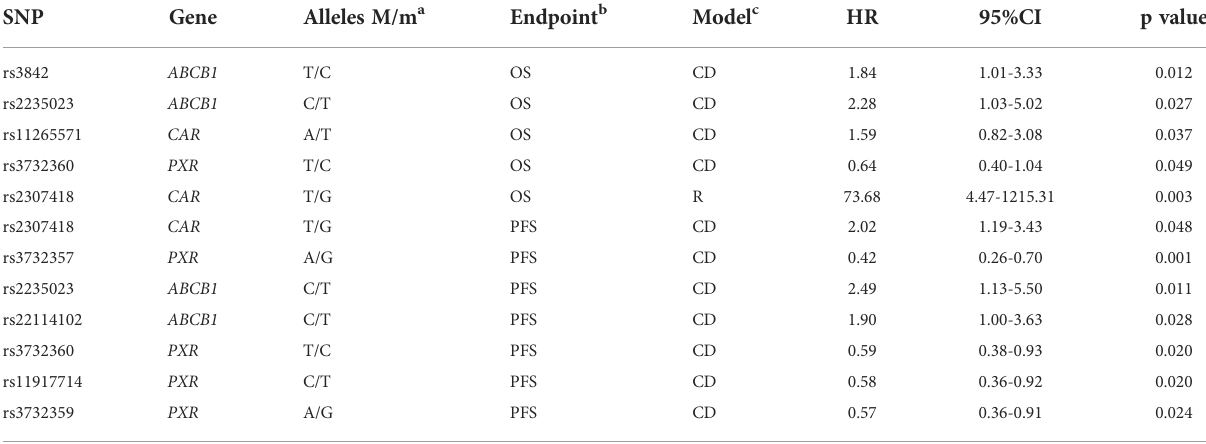
TABLE 3 Associations between selected SNPs, overall survival, and progression-free survival during dasatinib treatment. SNP